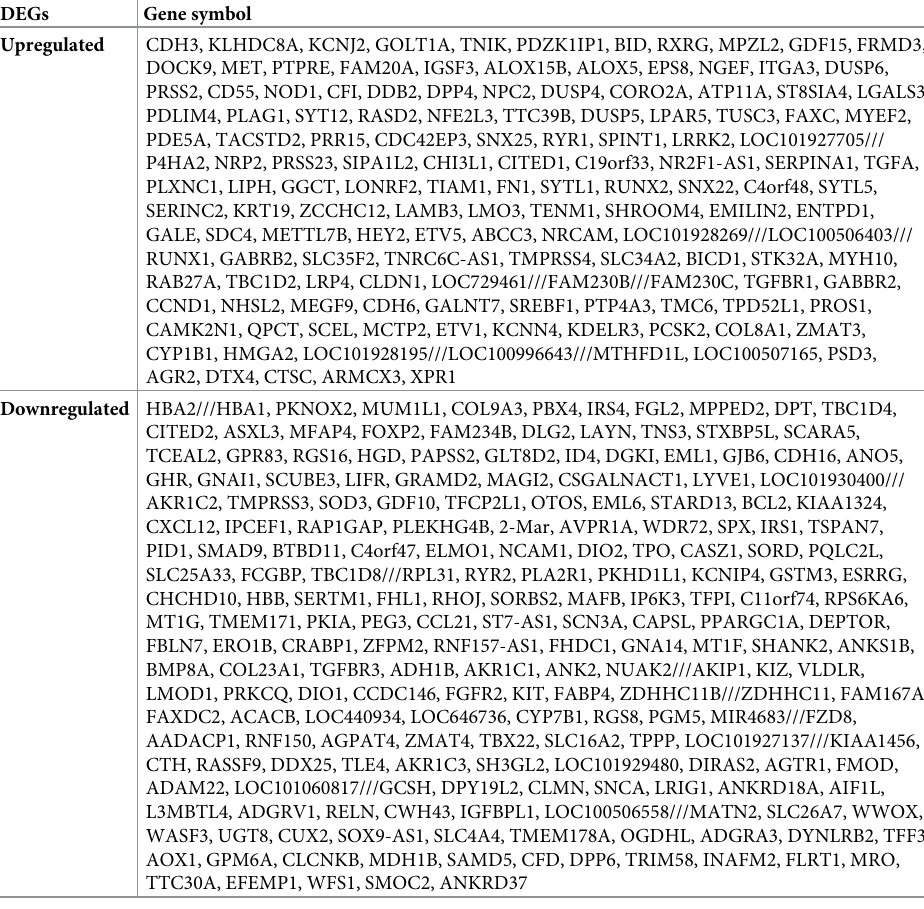
Table 1. Screening of 334 commonly differentially expressed genes from three profile datasets, including 136 upregulated and 198 downregulated genes in PTC tissues, compared to normal thyroid tissues.